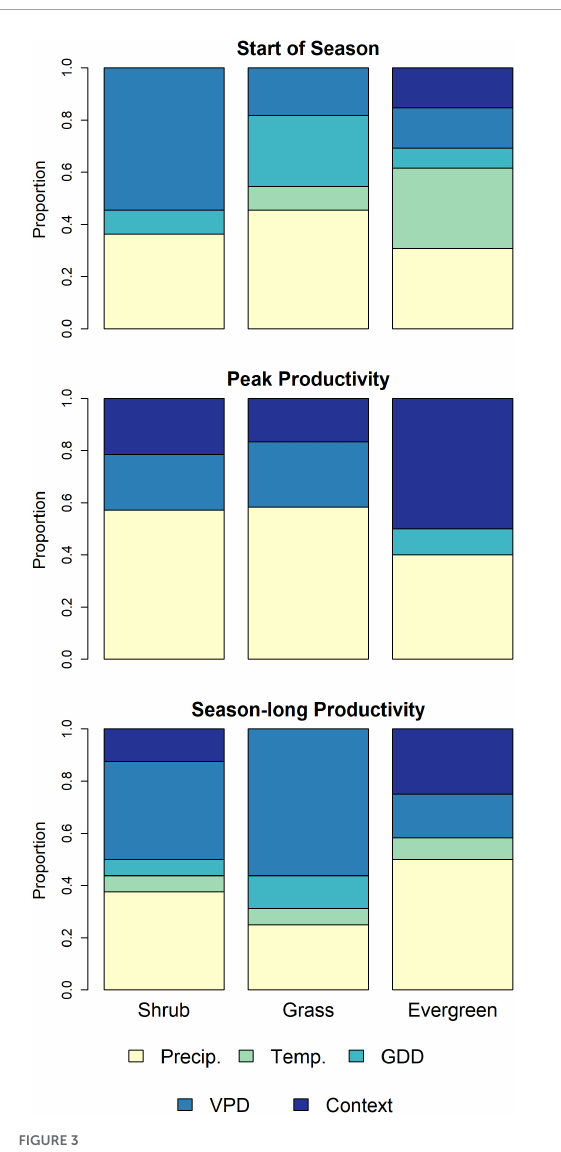
FIGURE3 Stacked bar plots indicating proportions of predictor variables derived from a random forest variable selection approach used to identify a set of drivers strongly associated with phenological measures for a given land cover type. Variable types represent different climate predictors (e.g., VPD, GDD) or contextual factors (e.g., soil characteristics or location). Results are presented for three phenological measure for three predominant land cover types in the U.S. Northwestern Plains. Evergreen, Evergreen Forest; Precip, Precipitation; Temp, Temperature; GDD, Growing Degree Days; VPD, Vapor Pressure Deficit; Context, contextual variables (i.e., soil, pixel composition, and location